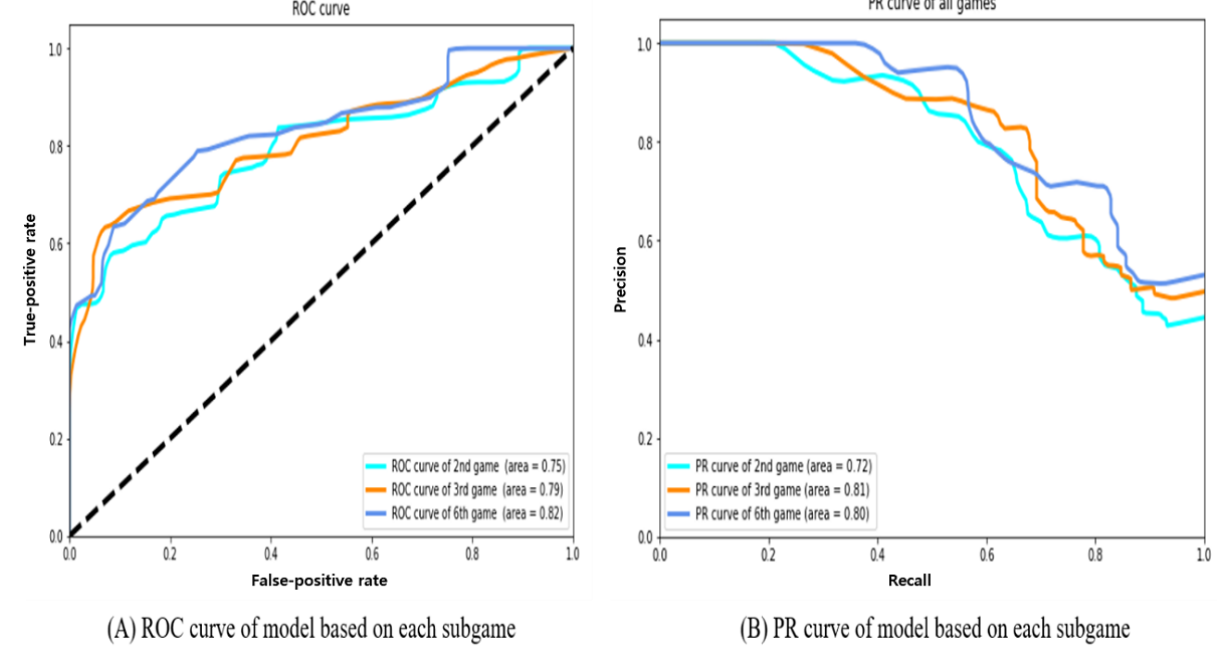
Prediction of Developmental Disabilities From